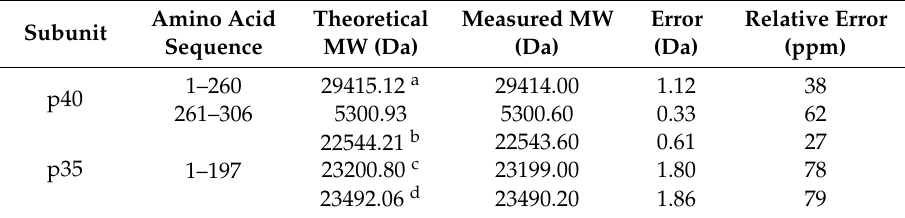
Table 2. Molecular weight (MW) of rhIL-12 (S01) by